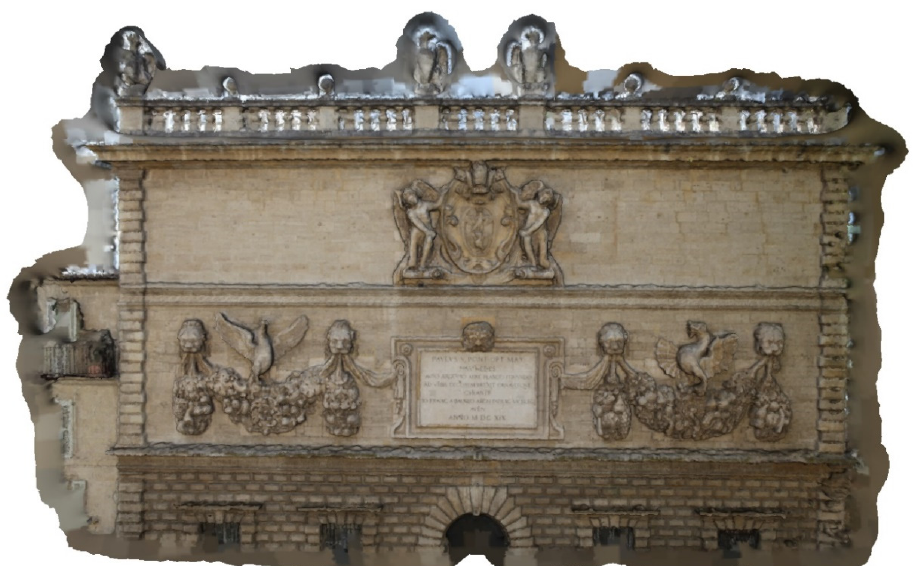
Figure 14. Texture model of the Hotel sequence that was reconstructed by the Poisson surface reconstruction. The textured model has a high geometry consistency with the real scene.